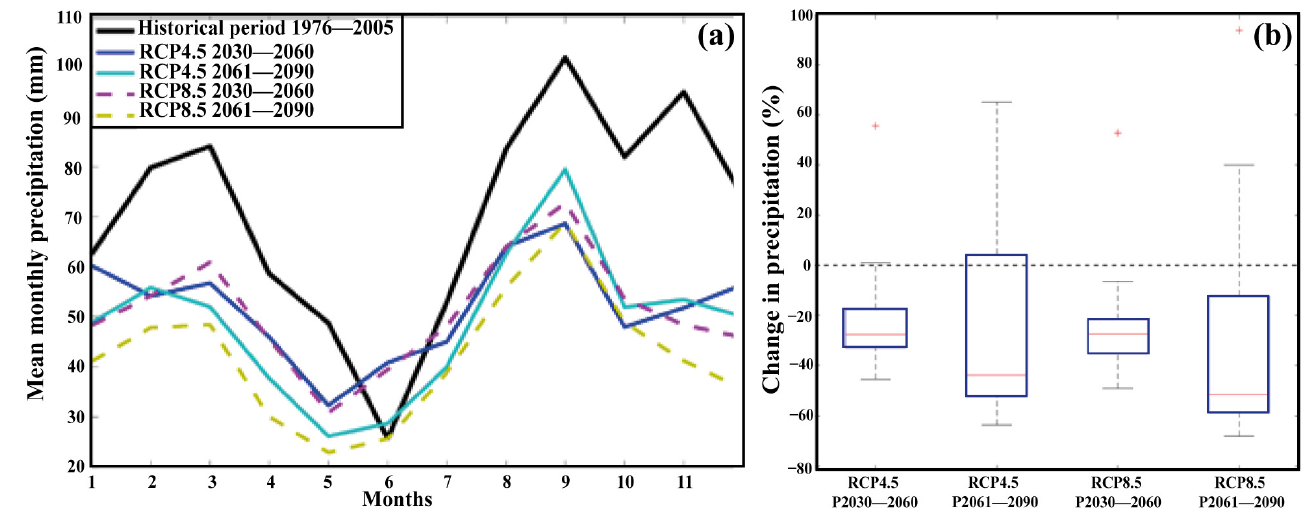
Figure 7. Future projected monthly precipitation ( a ) and future changes in precipitation by scenario and period ( b ).